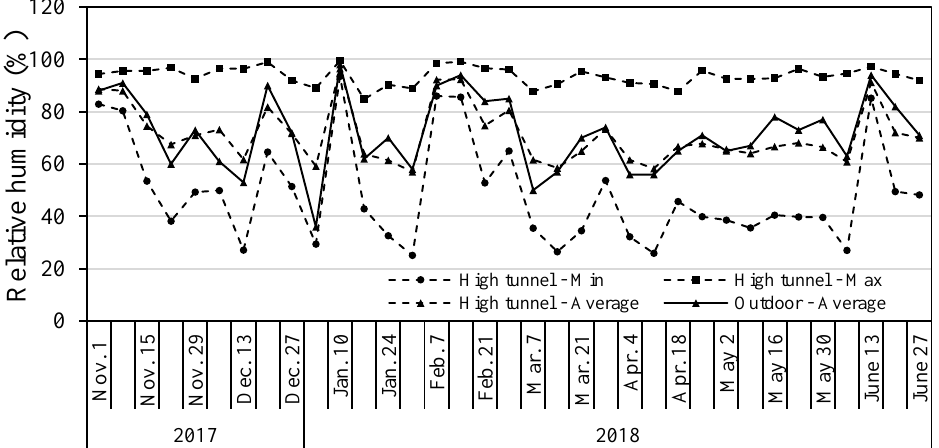
Figure 2. Daily minimum, average, and maximum relative humidity (RH) in the high tunnel and daily average RH outdoors from November 2017 to June 2018 in Starkville, Mississippi. Relative humidity in the high tunnel was recorded using a temperature and relative humidity sensor (HOBO S-THB-M002; Onset Computer Corp.); local outdoor RH data were obtained from the USDA Natural Resources Conservation Service website.